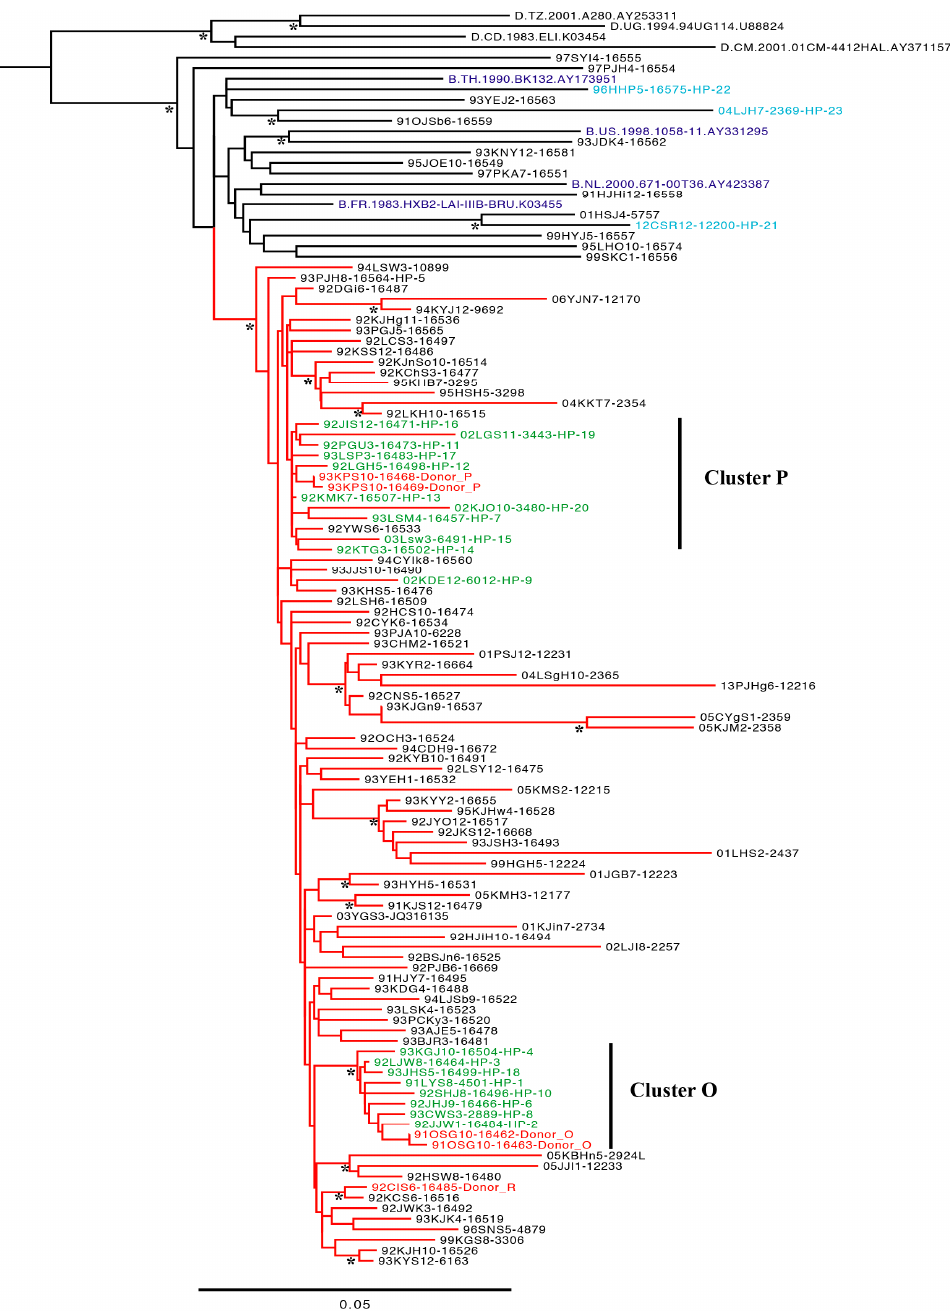
Figure 1. Phylogenetic tree of the earliest full-length gag gene sequences (1503 bp) of 110 Korean HIV-1 patients: 20 hemophiliacs (HPs); plasma donors O, P, and R; 71 local control patients infected with the Korean subclade of HIV-1 subtype B (KSB); and 16 non-KSB-infected patients (including three HPs, 21–23) infected with subtype B. Ninety-six sequences belonged to KSB (shown as a red horizontal line), and 16 subtype B Korean sequences and reference sequences are shown as a dark horizontal line. Nine patients, including donor O (Cluster O: 1–4, 6, 8, 10, and 18), strongly clustered within the KSB-infected local control patients. Sequences from donor P clustered with 10 HPs, leaving only two sequences—HPs 5 and 9—outside cluster P, although in more conserved full-length pol gene analysis, all 12 HPs clustered with donor P [2]. Three HPs (21–23) were infected by clotting factor purchased outside Korea (blue color). The two digits prior to patient IDs and the one or two digits after patient IDs denote the year and month of sampling, respectively. The reliability of the tree was evaluated by 1000 bootstrap replicates. The asterisks in the node show subclasses with more than 75% bootstrap